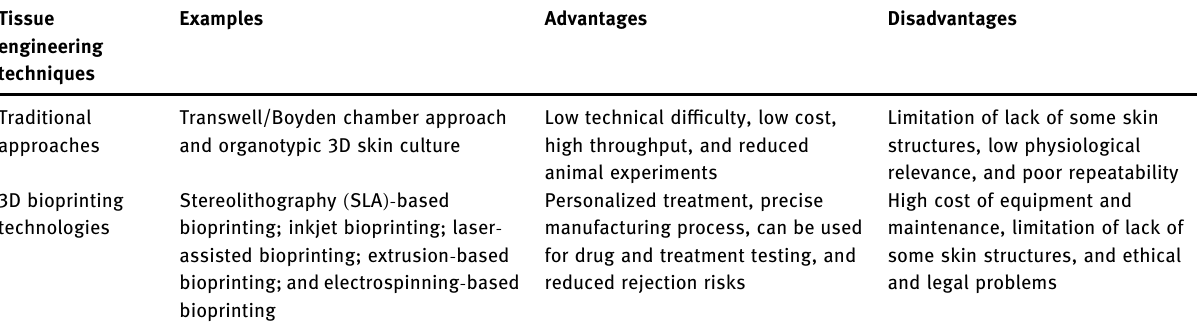
Table 1: Advantages and disadvantages of traditional approaches and 3D bioprinting technologies Tissue